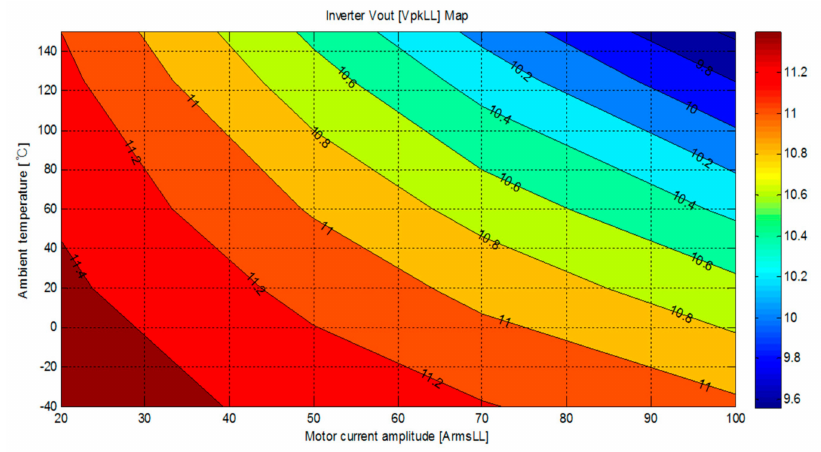
Figure 5. Map of the motor input voltage (inverter output voltage) for variation in the motor current amplitude and ambient temperature.